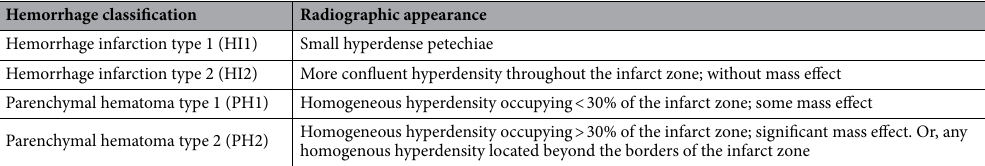
Table 1. The European Cooperative Acute Stroke Study scale of the hemorrhagic transformation after the thrombolytic treatment 43,44